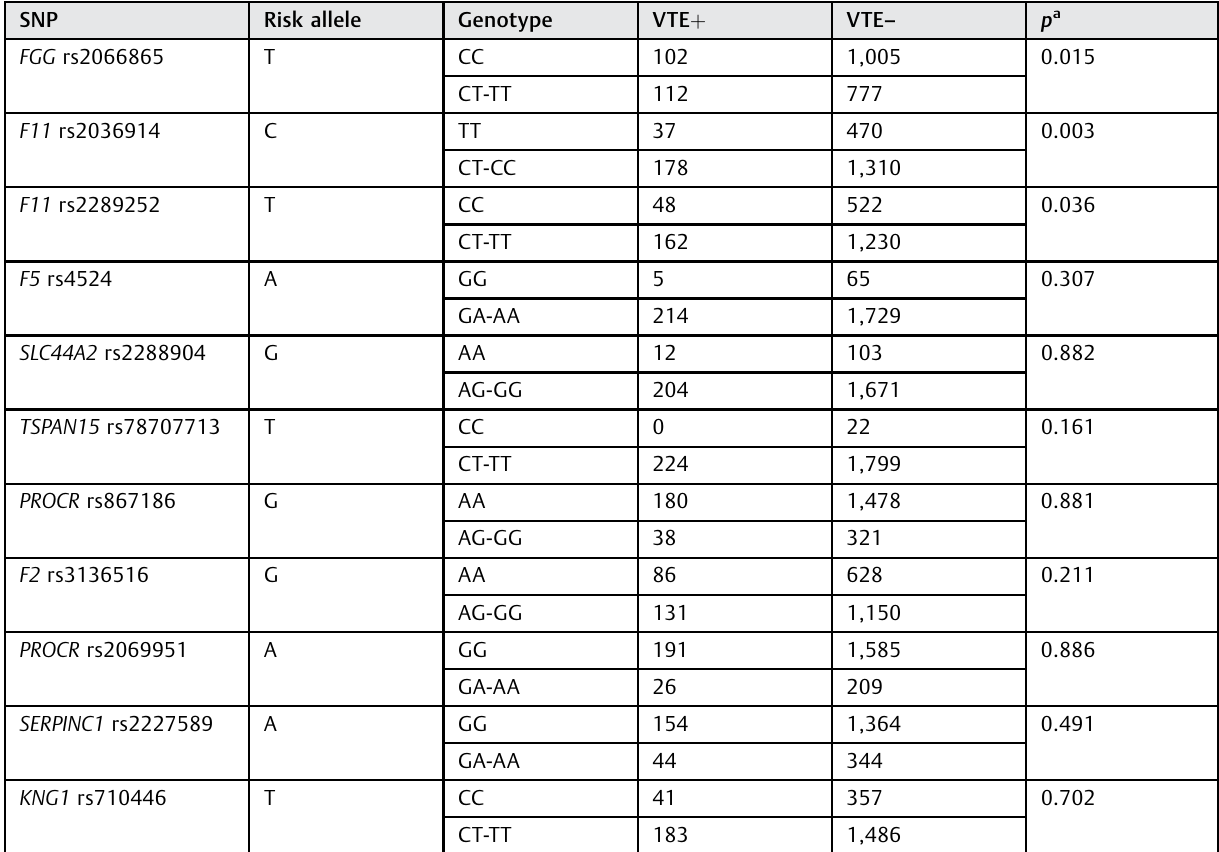
Table 2 Genotyping of 11 selected SNPs reported to be associated with VTE